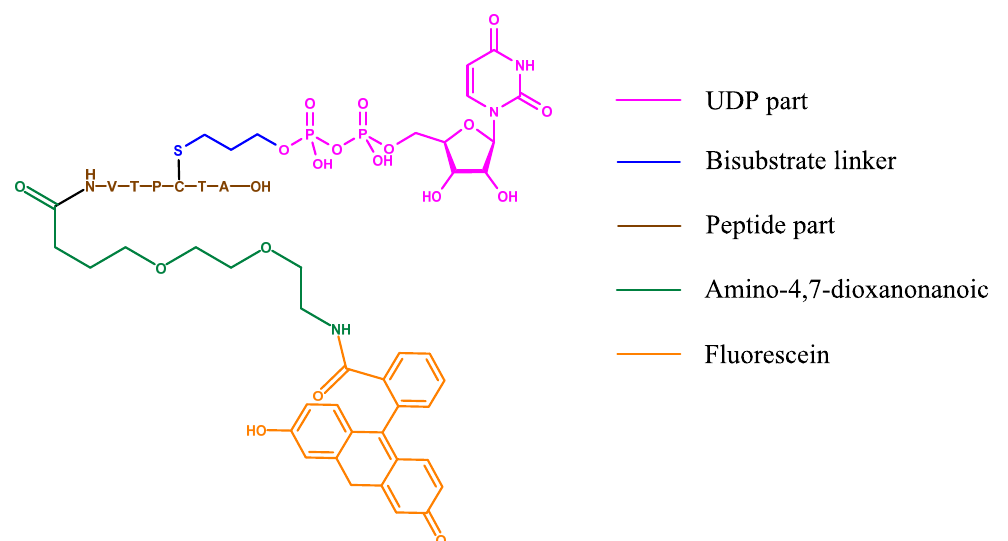
Figure 17. Structure of the bisubstrate probe used in the FP assay by the van Aalten group. The basis of this probe is OGT inhibitor Goblin1 that consists of UDP and a peptide substrate connected by a cysteine-thiol linker. Goblin1 is attached via flexible linker to a fluorescein derivative giving fluorescent properties to the probe.